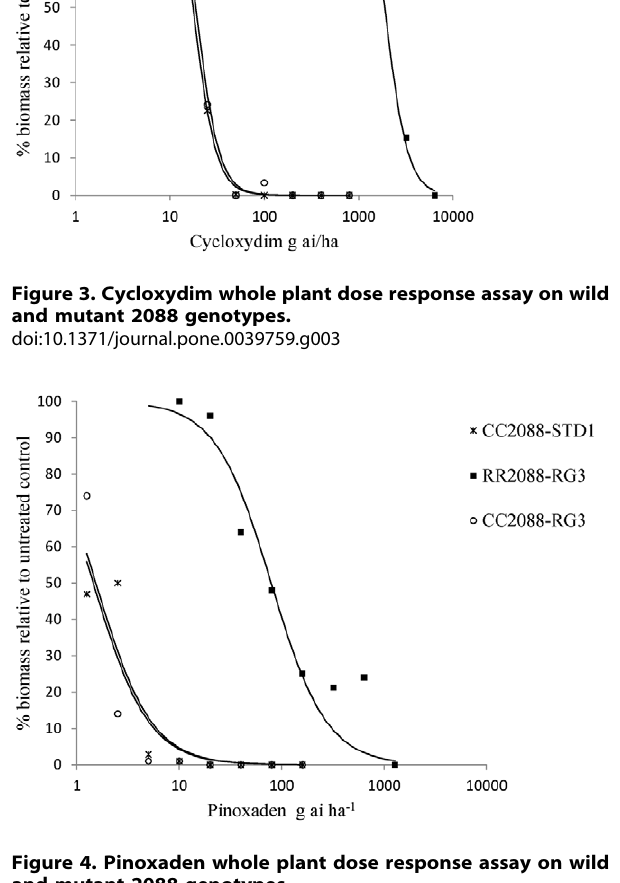
Figure 4. Pinoxaden whole plant dose response assay on wild and mutant 2088 genotypes.